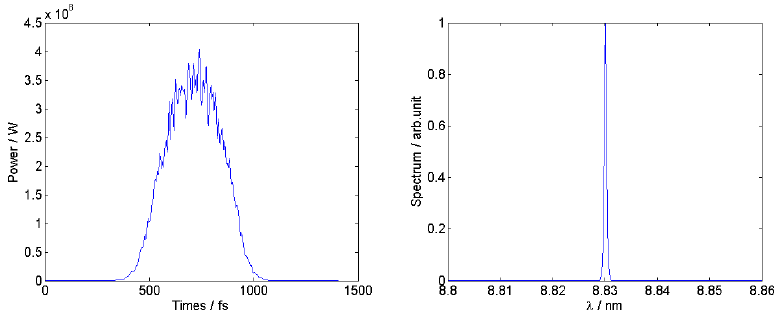
Figure 8. Simulated FEL performances of a single stage EEHG at the SXFEL-TF: final output pulse at 8.8 nm in time ( left ) and spectral ( right ) domain.